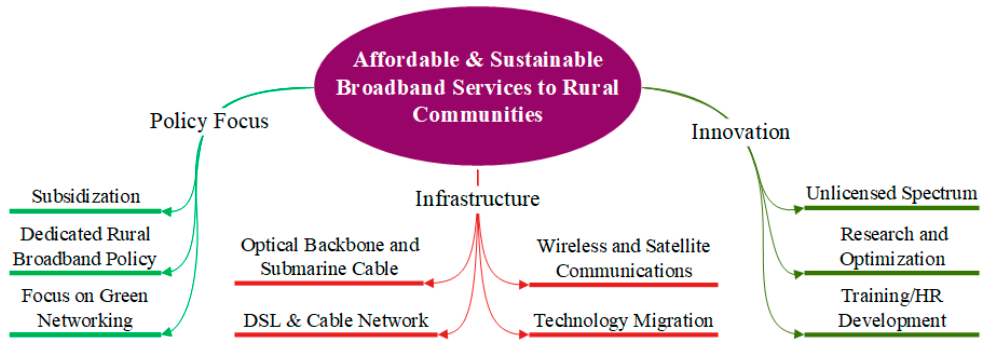
Figure 1. Focus areas for a ff ordable and sustainable broadband services. DLS, digital subscriber